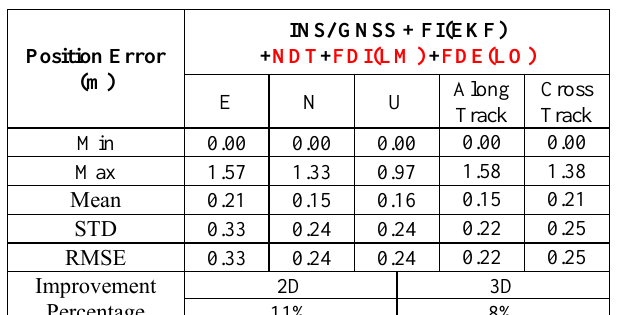
Table 5 . Performance analysis of initial pose with NDT. With the application of Fault Detection, Isolation and Exclusion scheme, faults in height, roll, and NDT transformation matrix are excluded. Hence, the accuracy of LiDAR-SLAM- based estimated solution is enhanced, the maximum error in height is remarkably reduced, the improvement in 2D reached 11%, 8% in 3D, as Table 6 shows. Dynamic map of the whole trajectory is depicted by LiDAR-SLAM-based estimated solution, plotted in Figure 10.